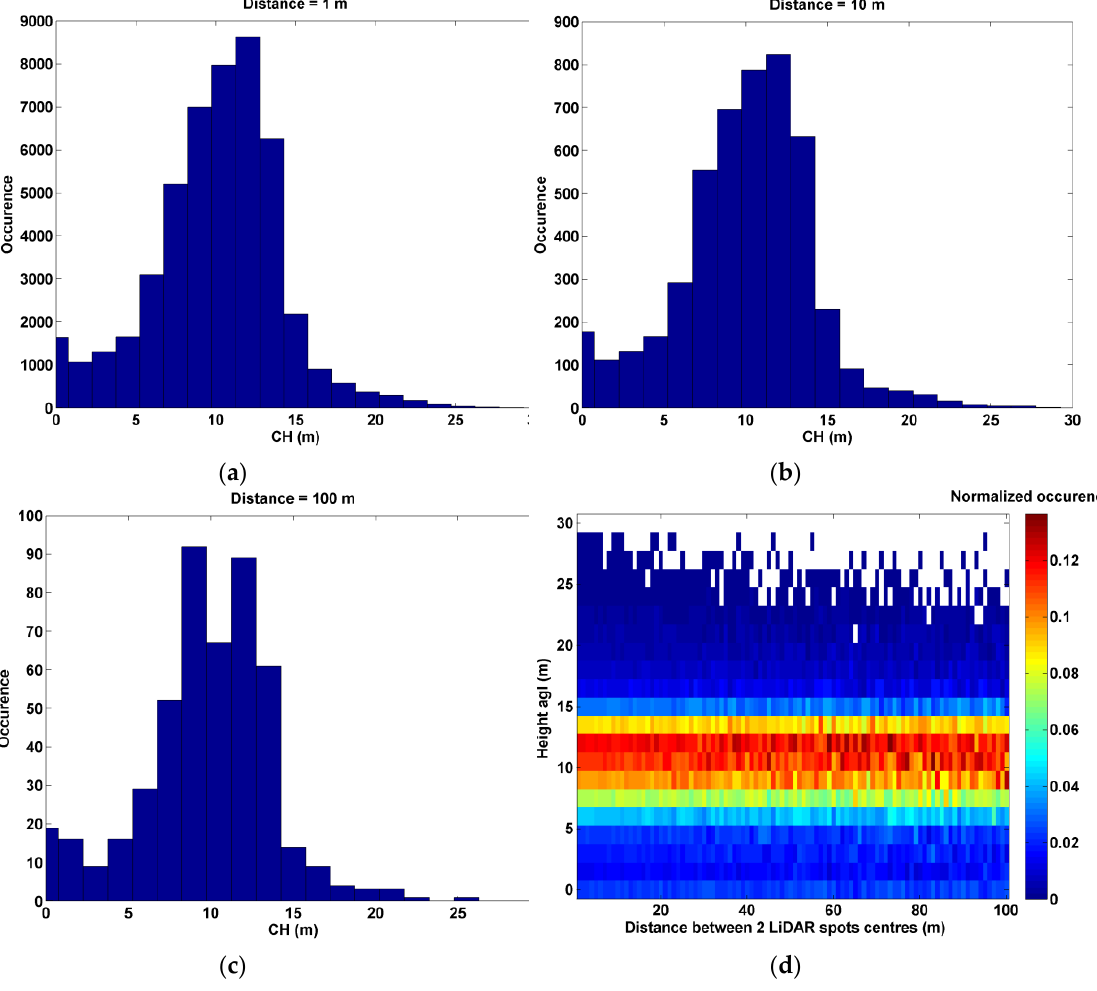
Figure 5. Distribution of the canopy height (CH) computed using a varying fraction of the LiDAR footprints in order to simulate an effective sampling distance between two consecutive footprints along the ULA ground-track of 1 m ( a ); 10 m ( b ) and 100 m ( c ). The two-dimensional representation is given in ( d ).